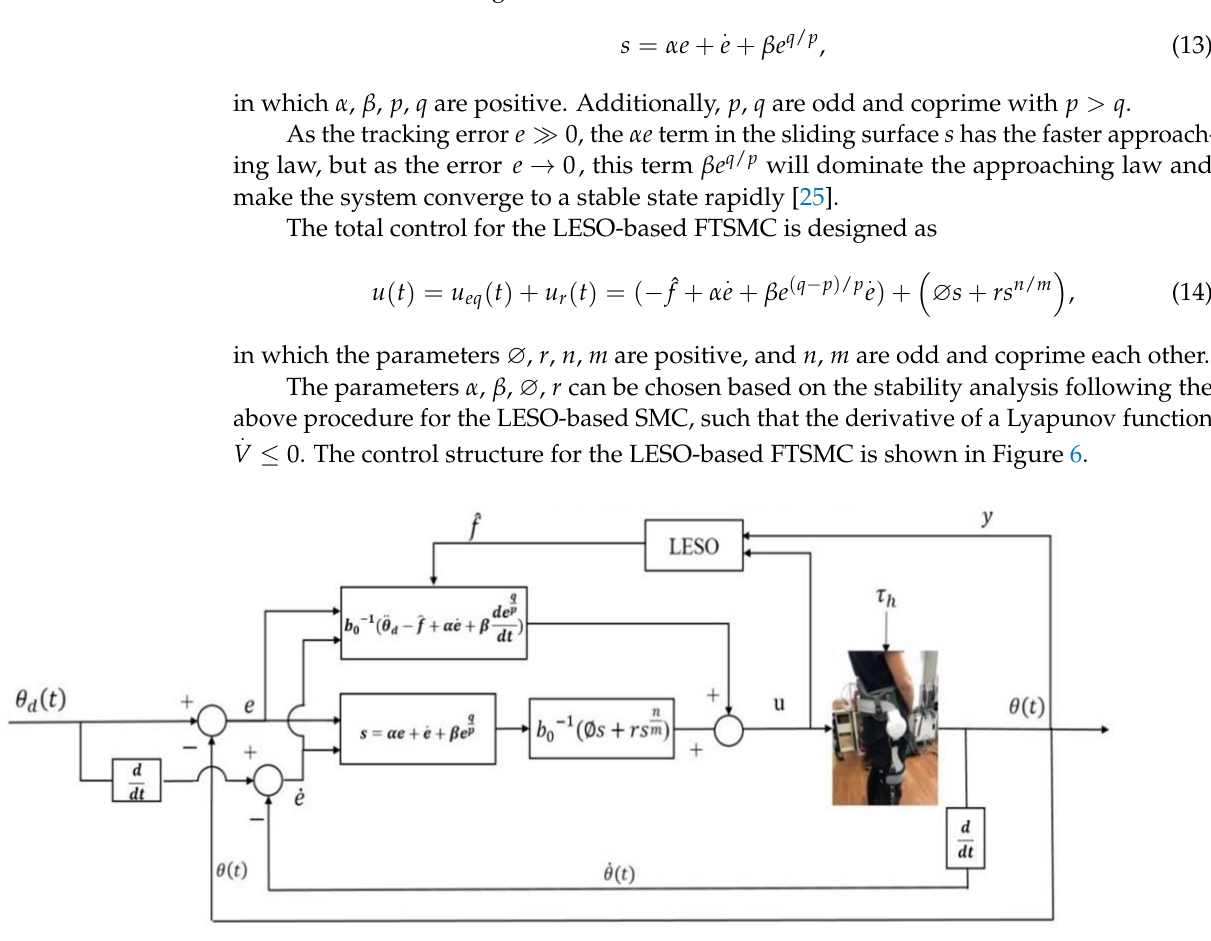
Figure 6. Control structure of LESO-based FTSMC.